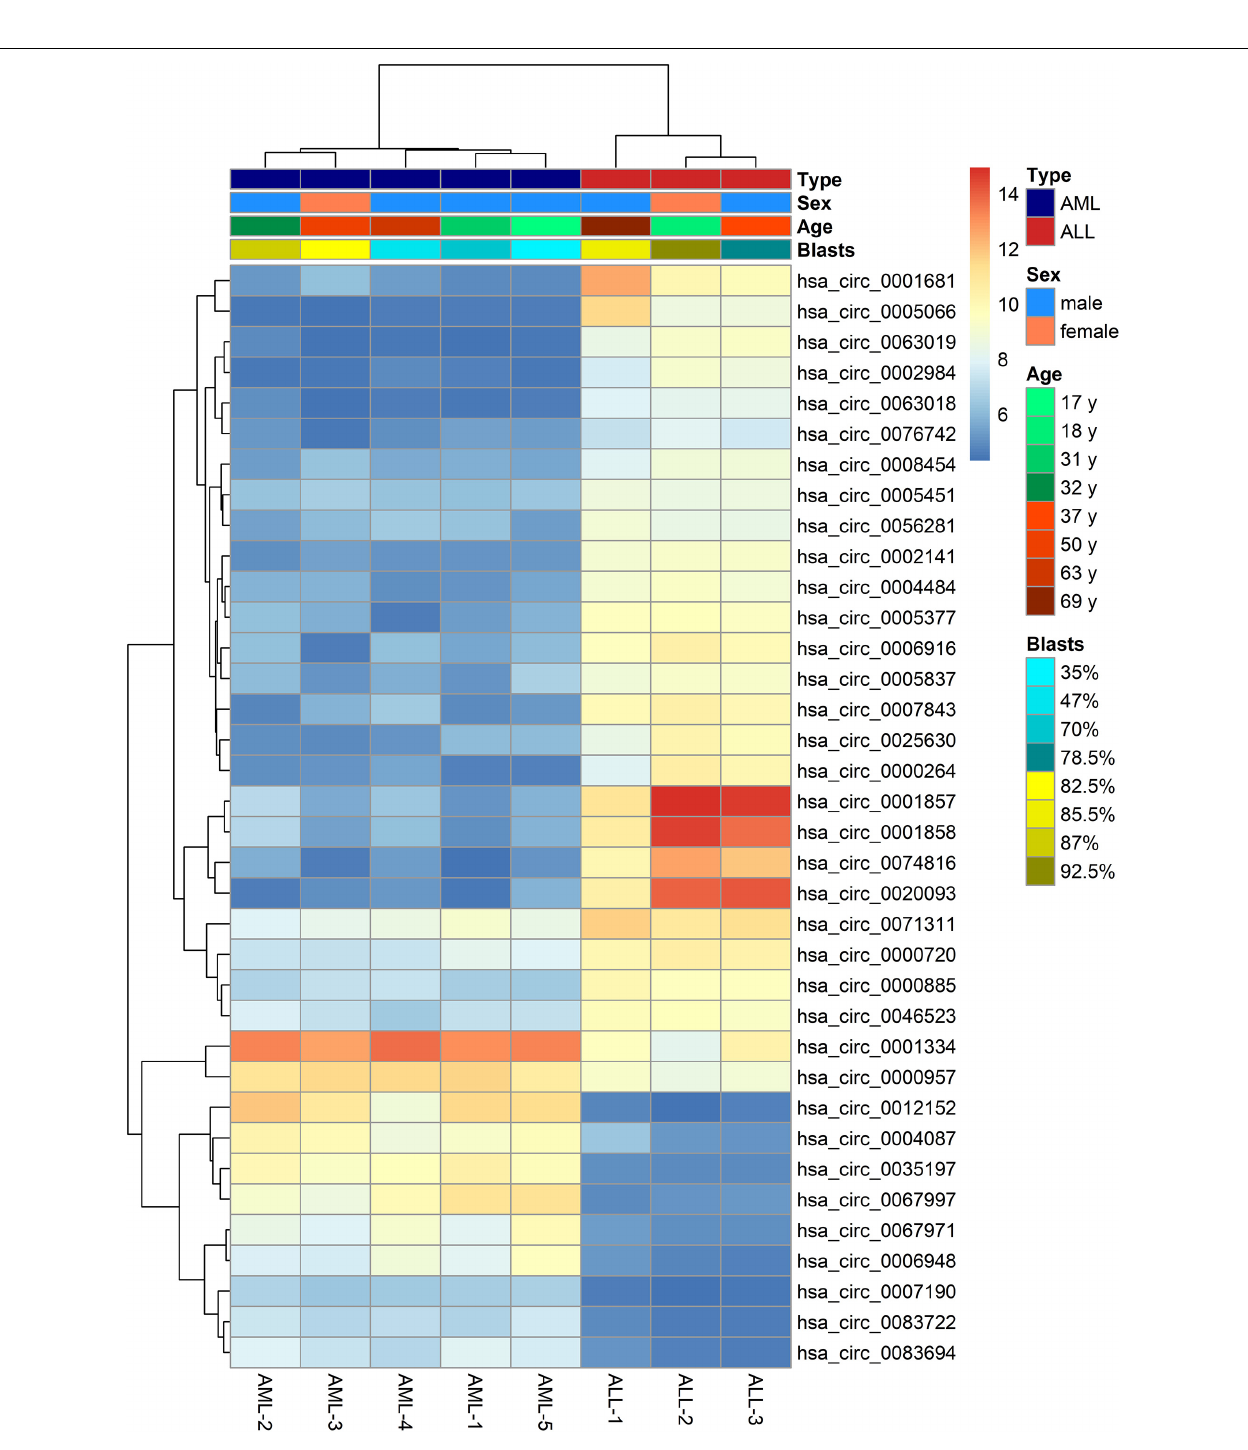
into two clusters based on their disease type rather than age, sex, or percentage of blasts. The five AML samples were grouped as a cluster, and the three ALL samples were grouped